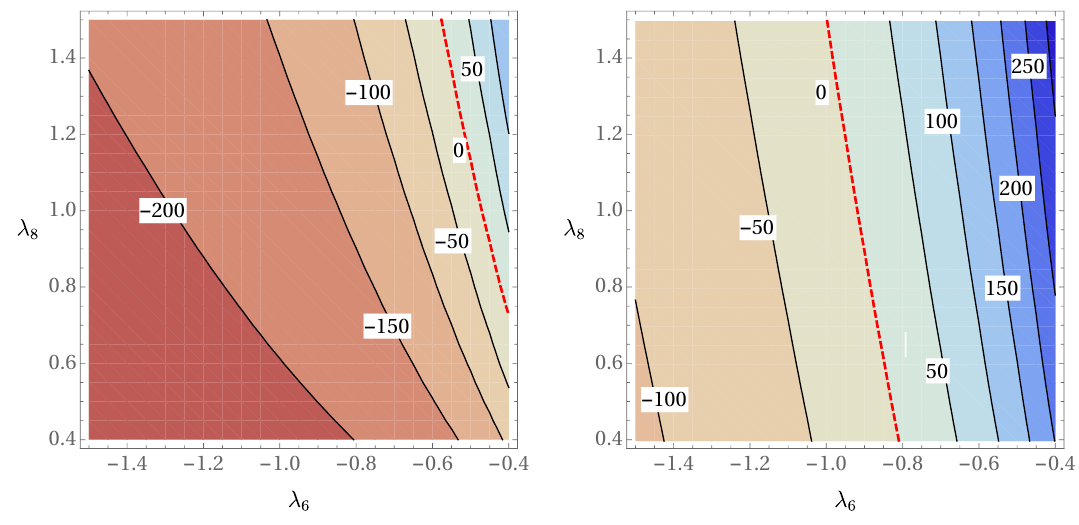
Figure 4 . Stability diagrams in the ( (cid:21) 6 ; (cid:21) 8 ) plane for log ( (cid:28)=T U ) with the potential of (2.25) and 10 parameters (cid:21) (cid:3) , (cid:11) , (cid:12) given in (2.19). Left panel : (cid:13)at spacetime case. Right panel : curved spacetime case. In each of the two panels, the black lines are curves with (cid:12)xed values of log ( (cid:28)=T U ) (reported 10 on it), while the thick red dashed line indicates the points where (cid:28) = T U . Colors serve as a guidance, indicating the decreasing of log ( (cid:28)=T U ) from the right to the left. Note that the inclusion of gravity 10 induces a broad enlargement of the region where the EW vacuum is stable (log ( (cid:28)=T U ) > 10